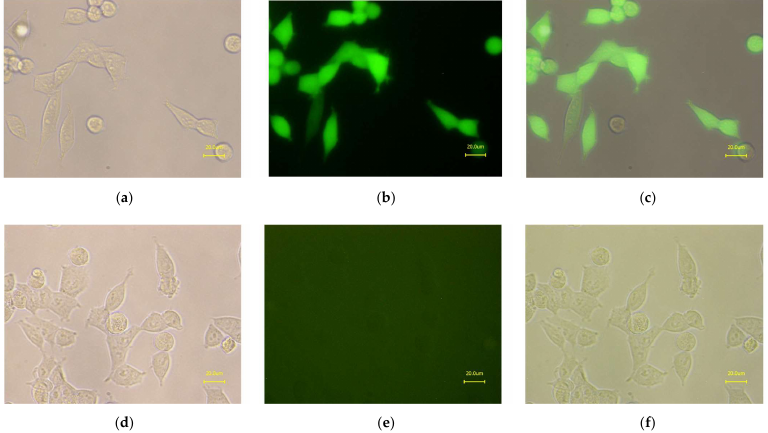
Figure 8. Presented are HEK-293 cells producing L19 antibody (stable cell line) after puromycin- induced selection in the bright-field ( a ), fluorescence ( b ), and overlay ( c ). In comparison, the HEK-293 wild-type cells are presented in the bright-field ( d ), fluorescence ( e ), and overlay ( f ) showing no GFP signal. The pictures were taken with the fluorescence microscope BZ-81000 (Keyence, Japan) with the object lens Plan Fluor ELWD 20 × /0.45 (Ph1 DM ∞ /0-2 WD 7.4, Nikon, Japan) under optical magnification 40x.